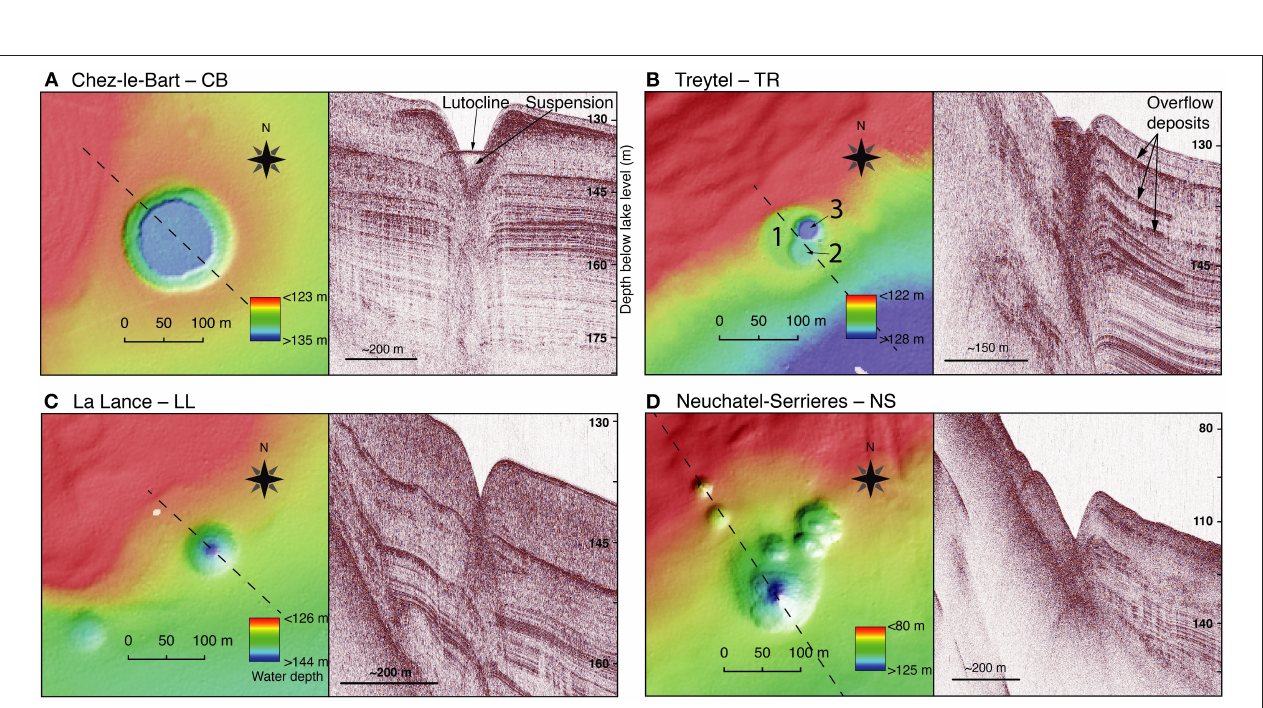
FIGURE 2 | Morphological details and reflection seismic profiles (3.5kHz pinger) of the four giant pockmarks. Dashed lines show position of seismic profiles. (A) Chez-le-Bart CB and (B) Treytel TR are pockmarks with chimneys filled with a sediment suspension; (C) La Lance LL and (D) Neuchatel-Serrieres NS are funnel-shaped pockmarks without sediment suspension. For (A) the interface between the sediment suspension and the lake water is highlighted (i.e., the lutocline), for (B) the overflow deposits that mark expulsion events in the past, as discussed in Loher et al. (2016) and Reusch (2016), are exemplarily marked. Also note the three generations of circular depressions that characterize the (B) TR pockmark (TR3, TR2, TR1). Data courtesy: Reusch (2016).